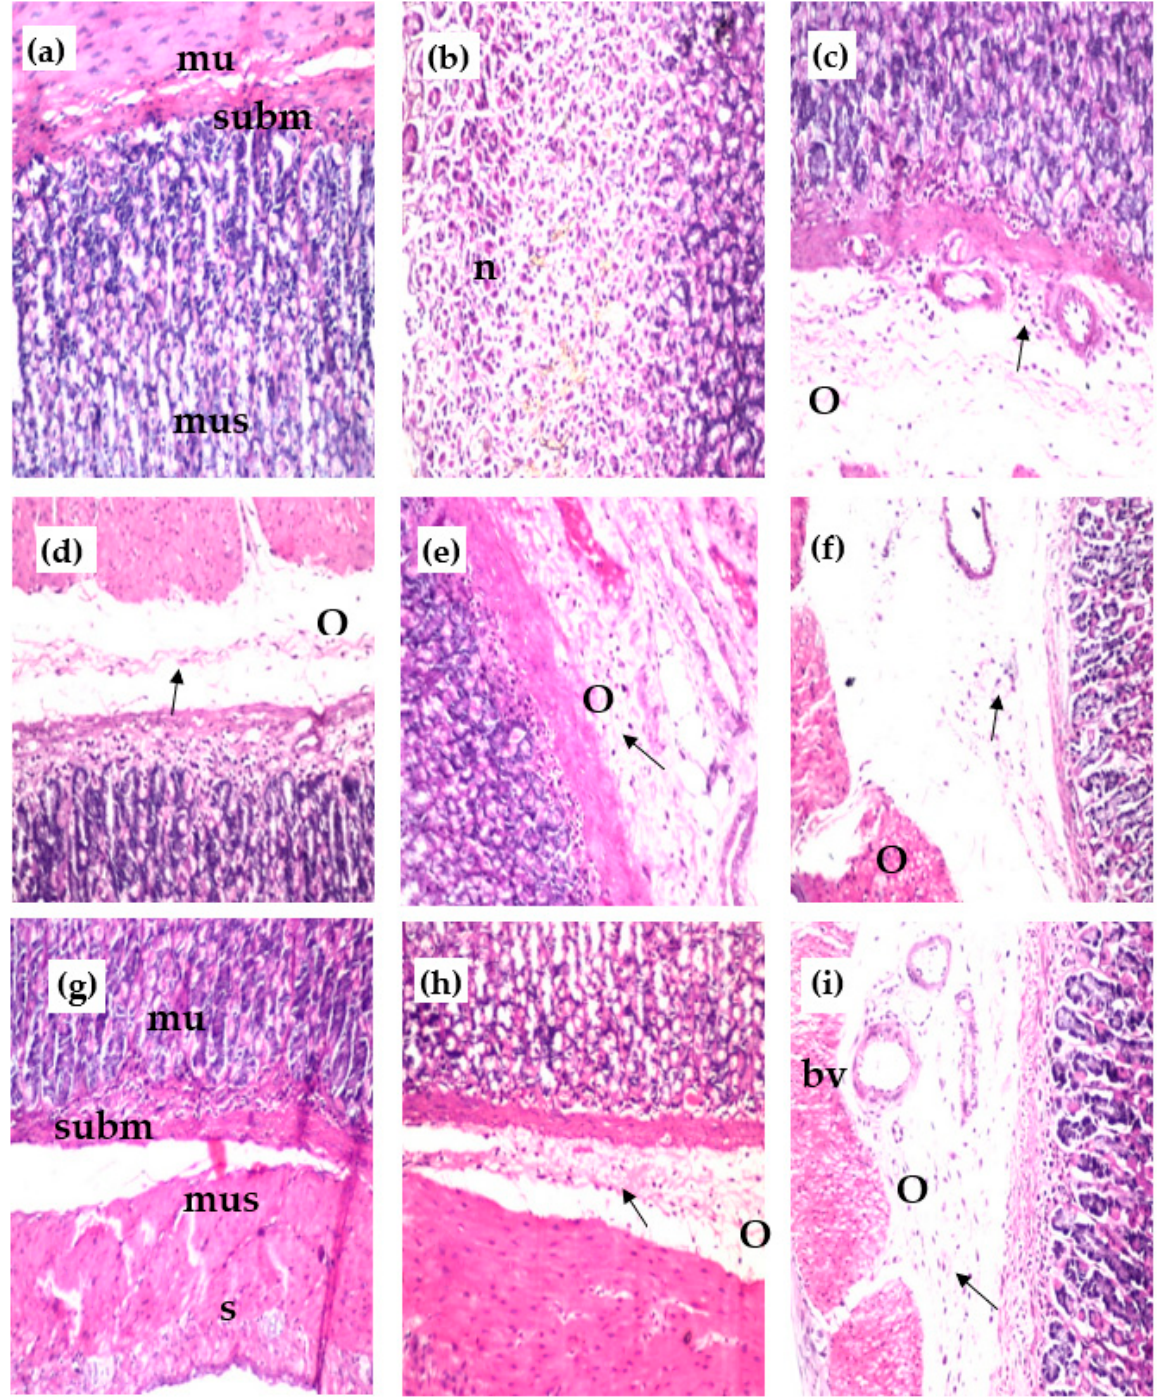
Figure 3. Effect of the various extracts of E. erinaceus on the histological structure of the gastric mu ‐ cosa of different treated rats’ groups stained with H & E stain (x40); ( a ) control group of normal rats; ( b , c ) ethanol ‐ induced ulcer group; ( d ) ethanol ‐ induced group + antodine; ( e ) ethanol ‐ induced group + MeOH ext; ( f ) ethanol ‐ induced group + n ‐ Hex. ext. ( g ) ethanol ‐ induced group + CHCl 3 ext. ( h ) ethanol ‐ induced group + EtOAc ext. ( i ) ethanol ‐ induced group + ReAq ext. mucosa = mu, submu ‐ cosa = subm, muscularis = mus, serosa = s, focal necrosis = n, oedema = o, inflammatory cells = arrow.